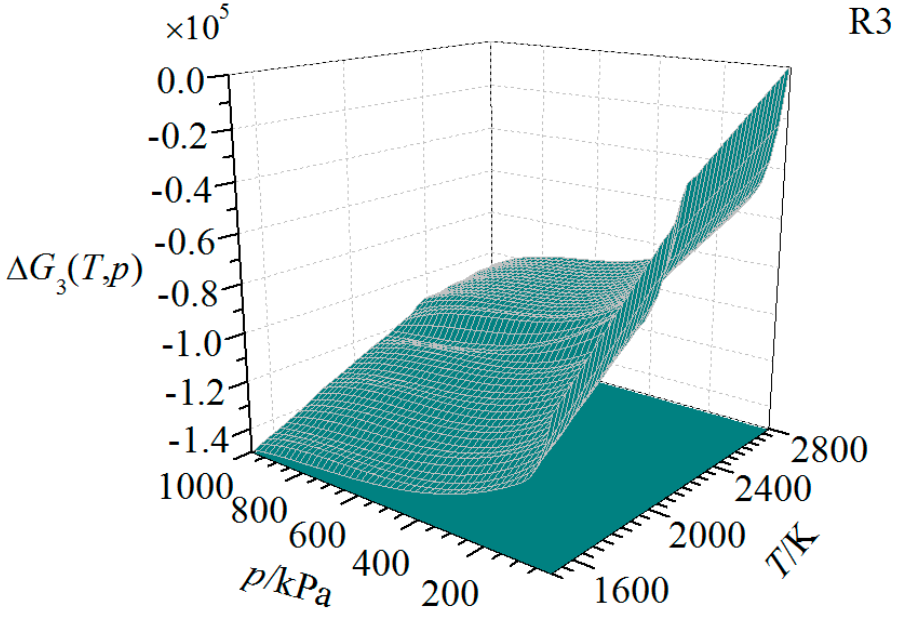
Figure 8. Gibbs energy dependence on temperature and Ca pressure for reaction R3.